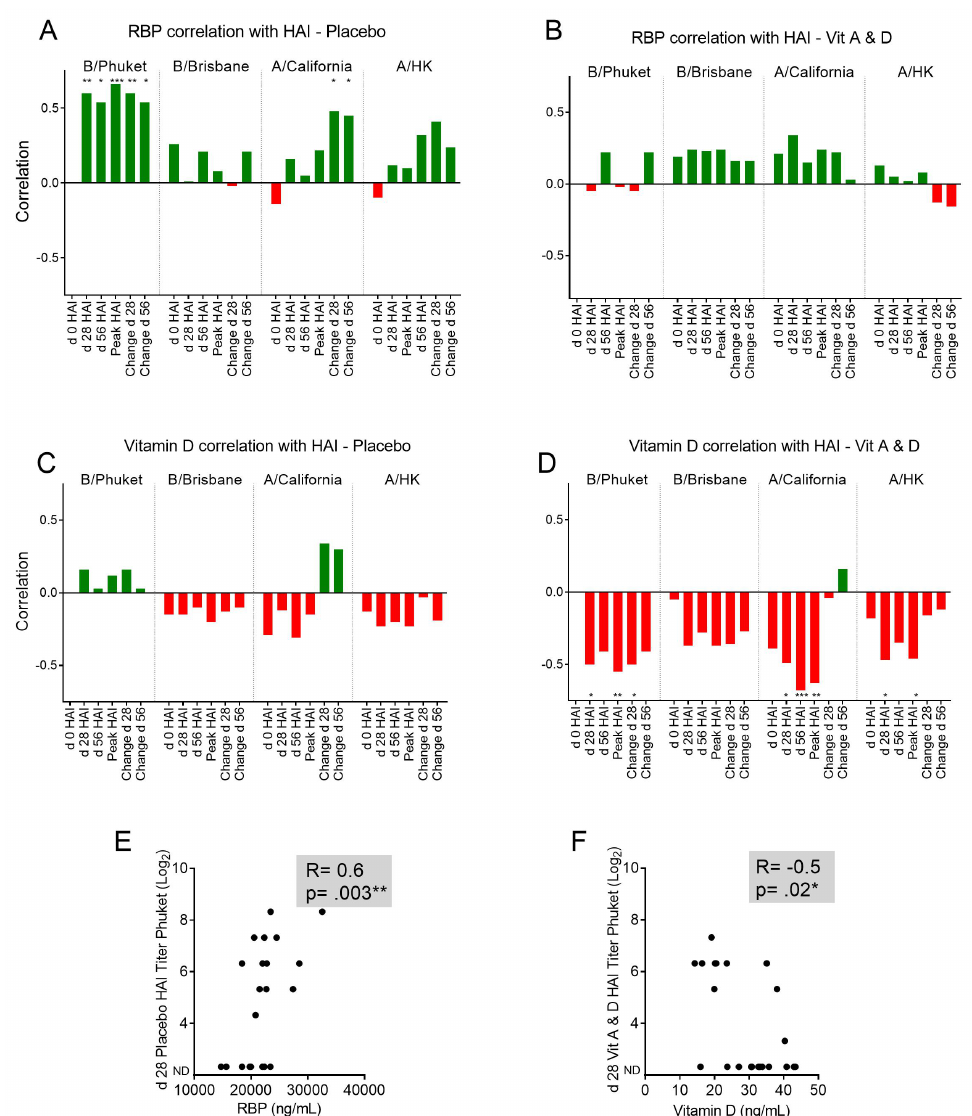
Figure 2. Relationships between baseline vitamin levels and HAI responses in season 2016–2017. Spearman correlation coe ffi cients are plotted for comparisons between baseline vitamin levels and HAI titers among participants enrolled during the 2016–2017 season. R values are plotted on the Y axis in A–D. Positive correlations are indicated in green and negative correlations are indicated in red. The top row shows RBP correlations with HAI titers in placebo ( A ) and A&D ( B ) groups. Specifically, correlations are shown between baseline RBP and day 0 HAI, baseline RBP and day 28 HAI, baseline RBP and day 56 HAI, baseline RBP and peak HAI, baseline RBP and changes in HAI between days 0 and 28, and baseline RBP and changes in HAI between days 0 and 56. * p < 0.05; ** p < 0.01; *** p < 0.001. The middle row substitutes 25(OH)D for RBP in placebo ( C ) and A&D ( D ) groups. In the bottom row, detailed correlative data are shown for RBP versus B / Phuket / 3073 / 13 HAI titers on day 28 in the placebo group ( n = 22, some values overlap) ( E ), and 25(OH)D versus B / Phuket / 3073 / 13 HAI titers on day 28 in the A&D group ( n = 22, some values overlap) ( F